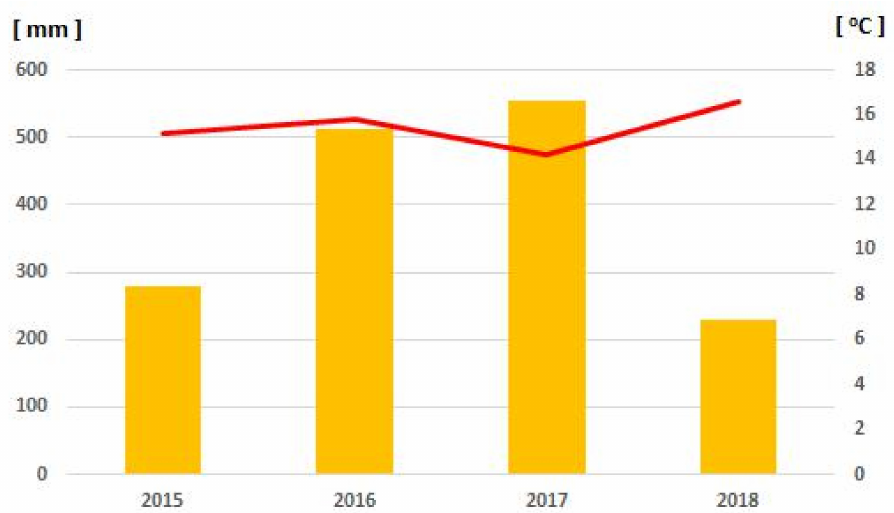
Figure 1. The sum of atmospheric precipitation and the average daily air temperature in maize growing seasons (columns—precipitation;